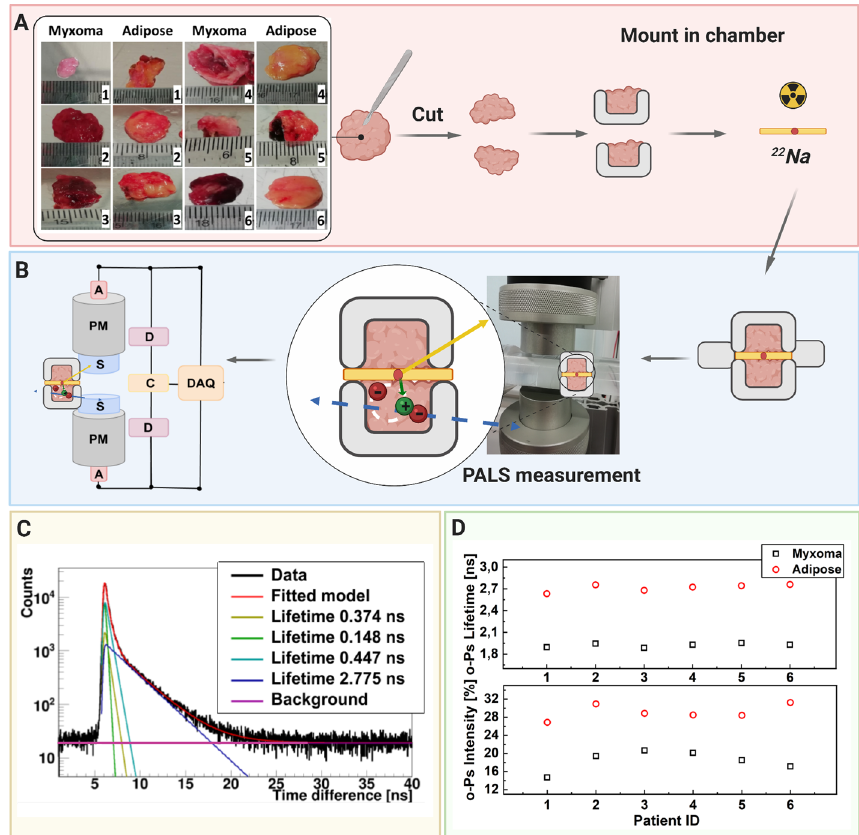
Fig. 4 A scheme showing positronium lifetime measurements in cardiac myxoma and adipose tissues. a Photographs of non-fixed cardiac myxoma (CM) and adipose tissue samples. The numbers indicate patient ID (Table 1). Each sectioned tissue has been cut in halves with a 22 Na radionuclide placed between and inserted into the aluminum measurement chamber. b The left part of the panel depicts the scheme of the detection system: scintillators (S), photomultipliers (PM), attenuators (A), discriminators (D), coincidence units (C), digitizer, and a data acquisition system (DAQ). The photograph displays a part of the system together with the plastic rod localized between the scintillators. The superimposed scheme indicates an aluminum chamber inserted inside the rod. 22 Na (red dot) emits (green arrow) positron ( ), which annihilates + (predominantly into two photons indicated in blue) with electrons ( ) in the tissue. Following the positron − emission, 22 Na changes into an excited nucleus of 22 Ne, which de-excites almost instantly by the emission of the de-excitation photon (indicated in yellow). The PALS detection system, enables the measurement of the positronium lifetime by registering the time of emission of the de-excitation photon (corresponding to the time of positronium formation) and the time of creating the annihilation photons (corresponding to the time of the positronium decay). c For each sample, 1 10 6 coincidences between annihilation and deexcitation × gamma quanta have been registered, resulting in the lifetime spectrum (example for the adipose tissue— patient ID 2). The analysis enables the extraction of the mean lifetime and intensities of para-Positronium (green line) and ortho-Positronium (blue line) atoms trapped in the intramolecular voids [42]. The dark yellow, turquoise, and purple lines denote direct annihilation in the source material, direct annihilation in the sample, and the background because of the accidental coincidences, respectively. The spectra are shifted by the delay coming from detection system configuration (~ 5 ns). d Results of the mean ortho-Positronium (o-Ps) lifetime (upper) and intensity (lower panel) for CM (black squares) and mediastinal adipose (red circle)